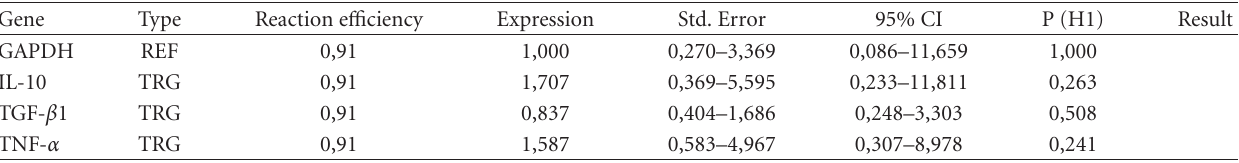
Table 3: Statistical analysis summary of results obtained from echinacea versus control after processing RT-PCR data through REST (Relative Expression Software Tool) in 40th day.